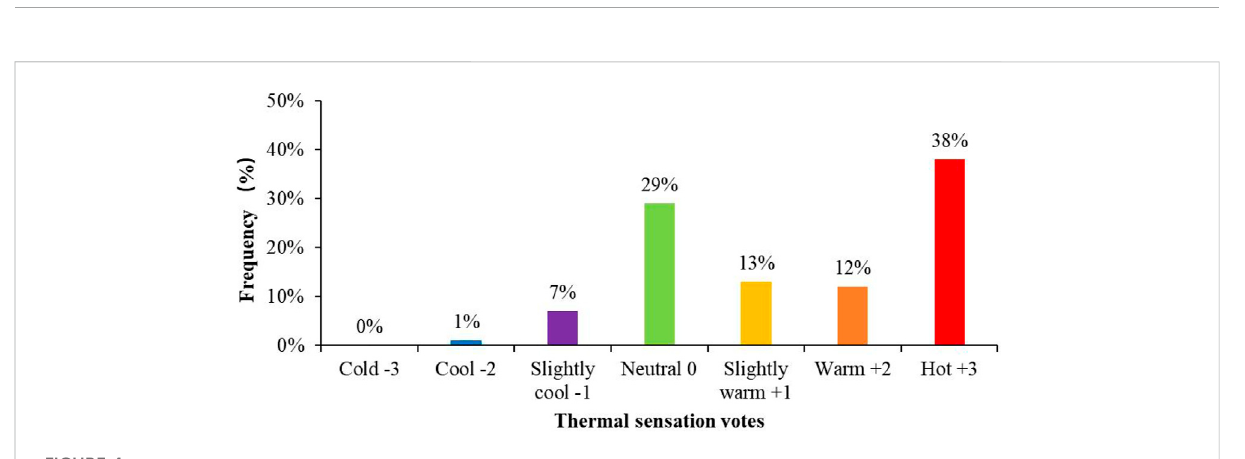
FIGURE 4 Frequency distributions of thermal sensation